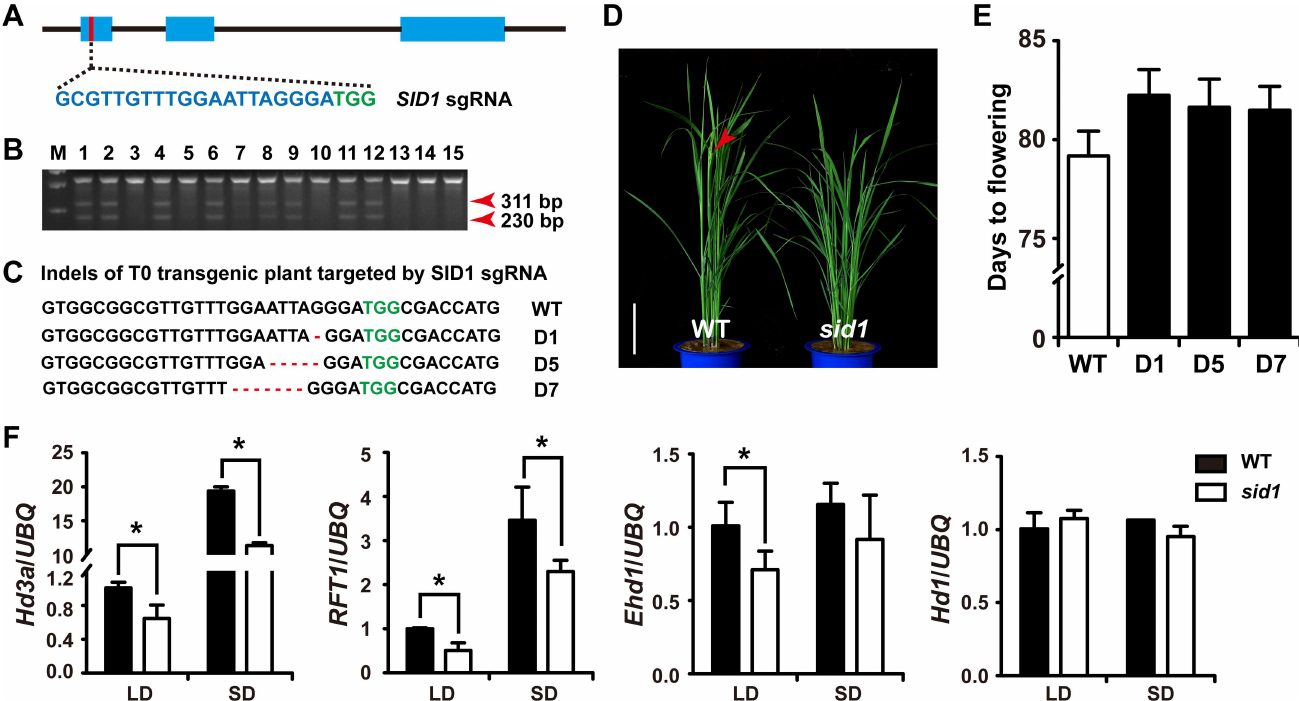
Fig 5. Generation and analysis of sid1 mutants. (A) Sites within a non-conserved regionof the first exon of SID1 targeted by the CRISPR-Cas9 system. The PAM sequence(TGG) of the sgRNA target is green and the sgRNA target is cyan. (B) Outcome of CEL I assay to detect CRISPR-induced mutationsin 15 representativeT0 transgenicrice plants. Red arrowheads indicate the fragments digested by CEL I. (C) Representative sequencesof mutant allelesidentifiedfrom transgenic plants of the SID1 sgRNA target. D1, deletionof 1 bp; D5, deletionof 5 bp; D7, deletionof 7 bp. (D) One representative T1 transgenicplant of the SID1 sgRNA target showinga late-flowering phenotype at headingstage. Red arrowheads indicatethe panicle.Scale bar, 15 cm. (E) Floweringtime of sid1 and WT plants under NLD conditions. Three independentmutant lines (D1, D5, and D7) were used for analysis.Data are means ± SD ( n = 40). Student’s t -test was appliedto determine significantdifferences( P < 0.05). (F) Quantitative RT-PCR analysisof Hd3a , RFT1 , Ehd1 , and Hd1 in sid1 and corresponding wild type (WT) under short-day (SD) and long-day(LD) conditions. The transcript levels of each gene were normalized to the rice UBQ gene. Values are shown as means ± SEMs of three biologicalreplicates and each with two technicalrepeats. Asterisks denotesignificantdifferences (P < 0.05, Student’s t